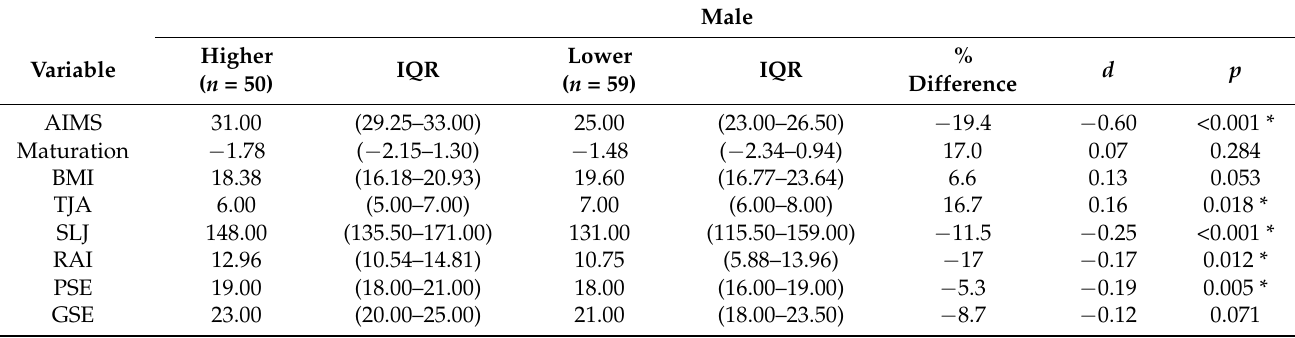
Table 6. Differences in characteristics between groups based on AIMS score in boys.